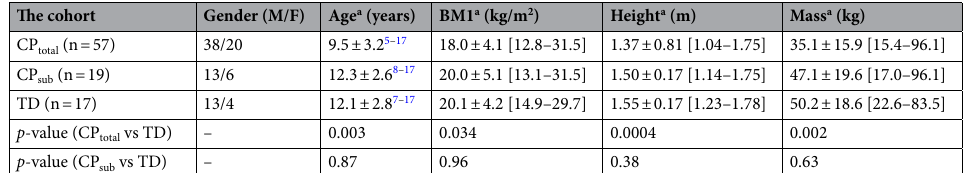
Table 1. Participant characteristics. a The table shows the mean ± SD [range] of the participant characteristics. CP total here refers to the entire CP cohort in this study. CP sub is a subset of 19 participants where all of the CP sub was imaged with similar MRI protocols, which are similar to the TD cohorts’ MRI protocols.